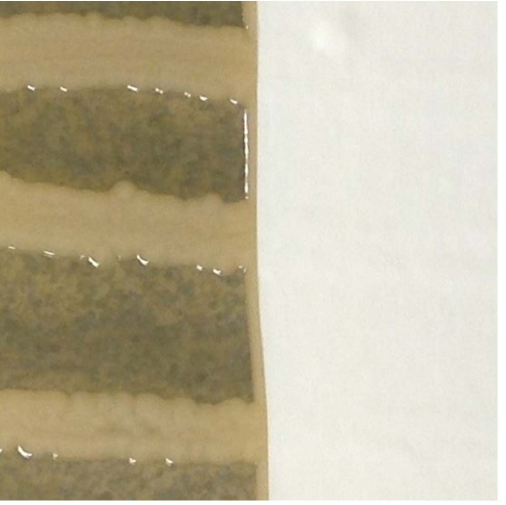
Figure 4. Typical results, nitrile gloves with no inhibition of Klebsiellapneumoniae demonstrated.